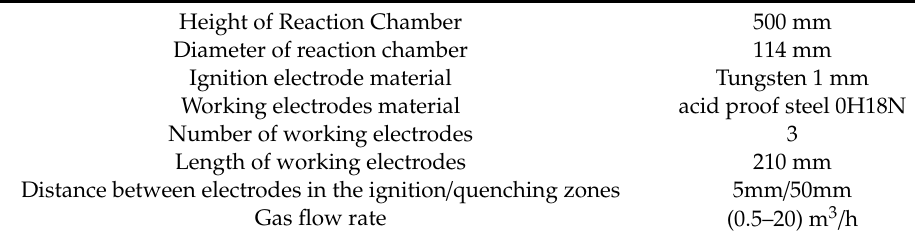
Table 1. Technical specification of GAD reactor [53].